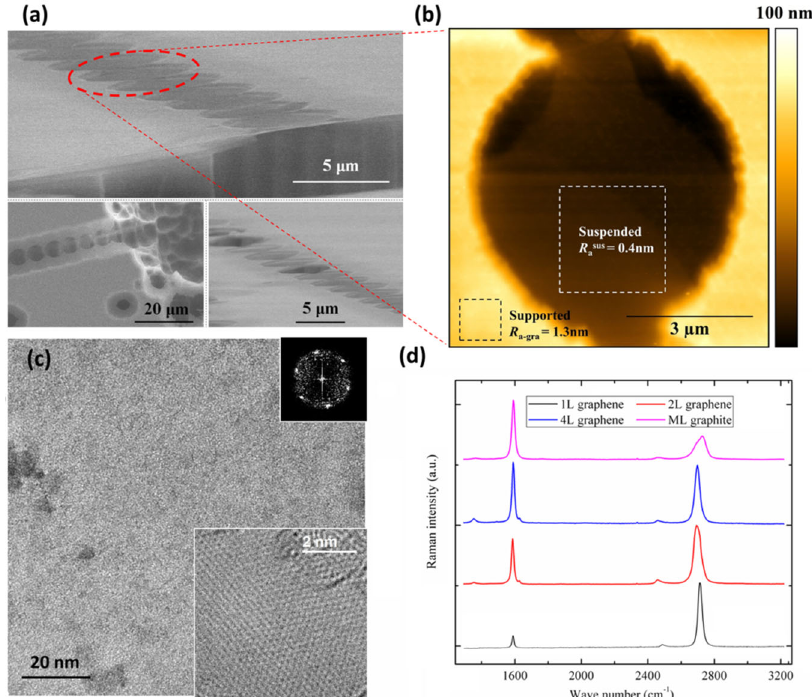
Fig. 2 Surface characterization of 1 L graphene. a Scanning electron microscopy (SEM), b atomic force microscopy (AFM) height image of an area